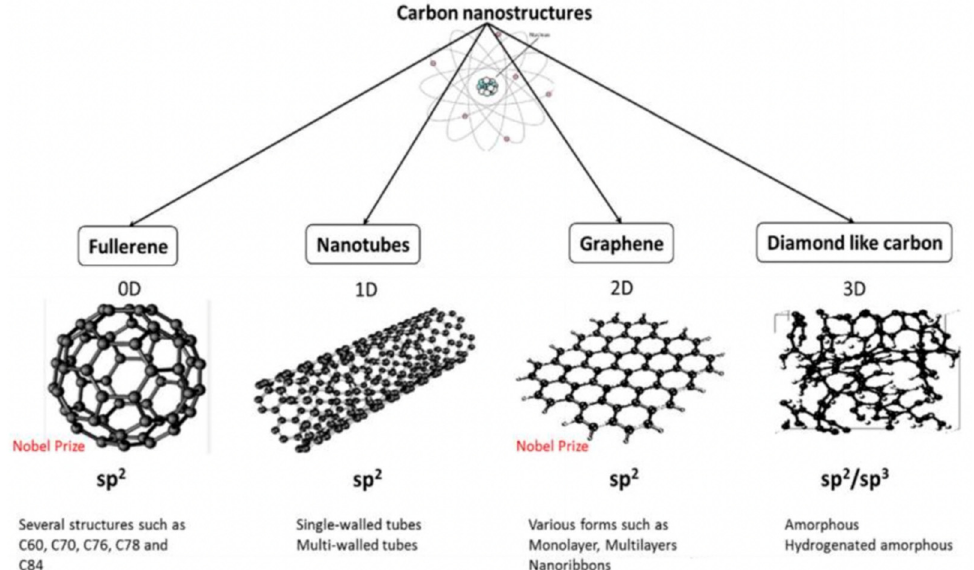
Figure 4. Carbon-based nanomaterials categorized via different dimensionalities (D). (Adapted with permission from Ref. [116]. 2017, Al-Jumaili et al. More details on “Copyright and Licensing” are available via the following link: https://www.mdpi.com/ethics#10 (accessed on 10 October